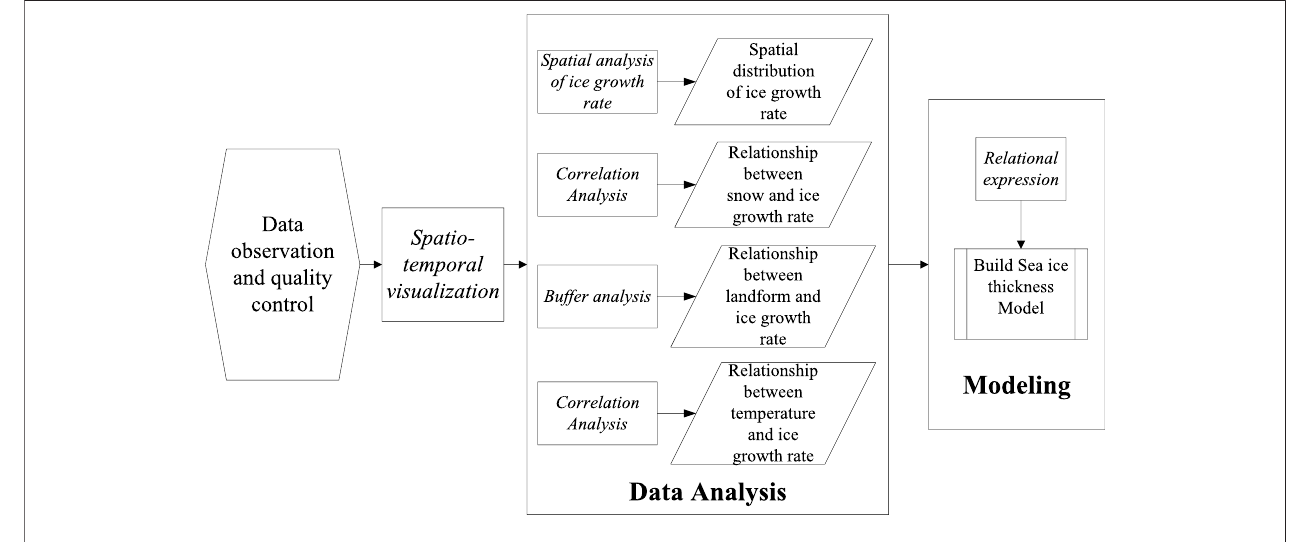
FIGURE 2 | Technical